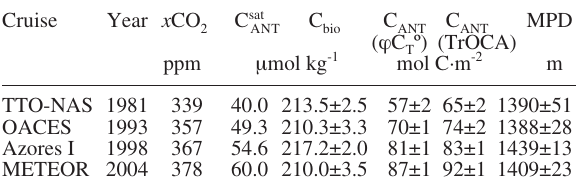
Table 1. – Specific inventories of C the Azores region (10-35ºW and 26-42ºN). The error of the aver- aged C storage is expressed as a standard ANT